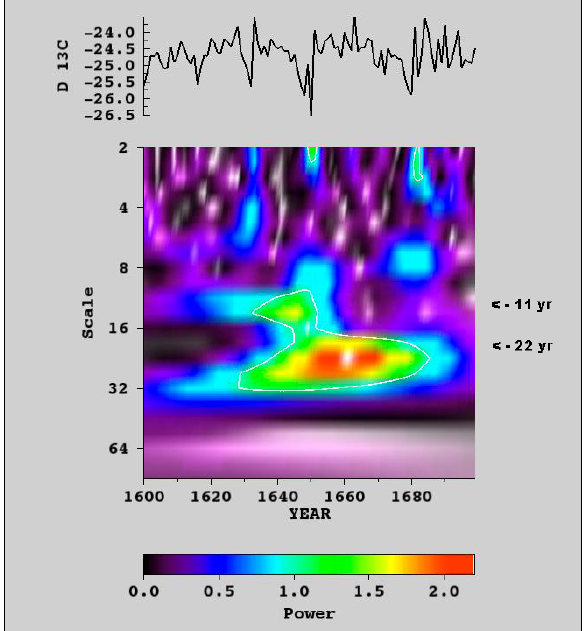
13 C data δ 13 C data. δ